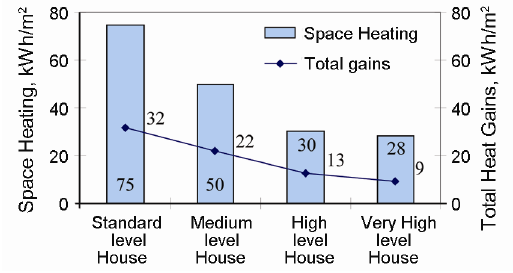
Fig. 10. The influence of heat gains on space heating demand